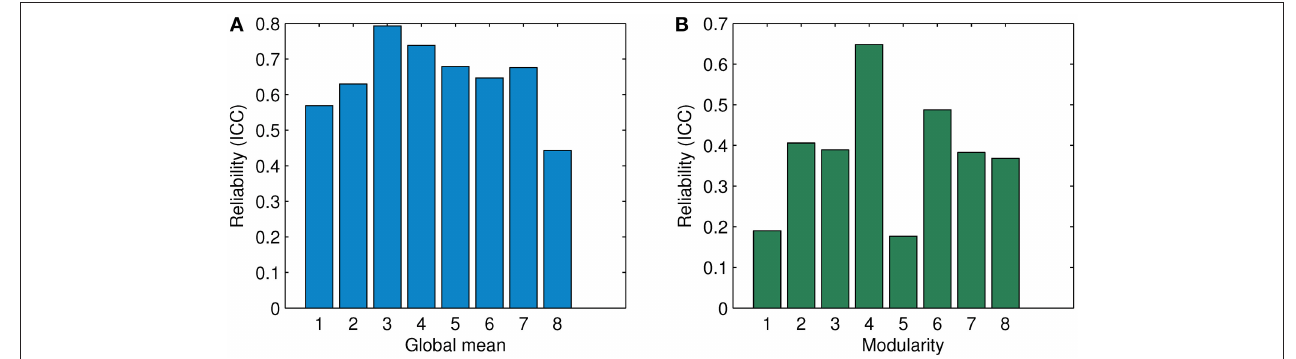
FIGURE 10 | Comparison of ICC in terms of the global mean and the modularity for association matrices obtained by ASR and the Pearson correlation. (A) Reliability (ICC) in terms of the global mean. (B) Reliability (ICC) in terms of modularity. The digits “1” through “6” denote the condition of λ being 1, 0.5, 0.1, 0.01, 0.001, and 0.0001 for ASR respectively. The digits “7” and “8’ show the average ICC value for ASR over all six conditions and the ICC value of the Pearson correlation